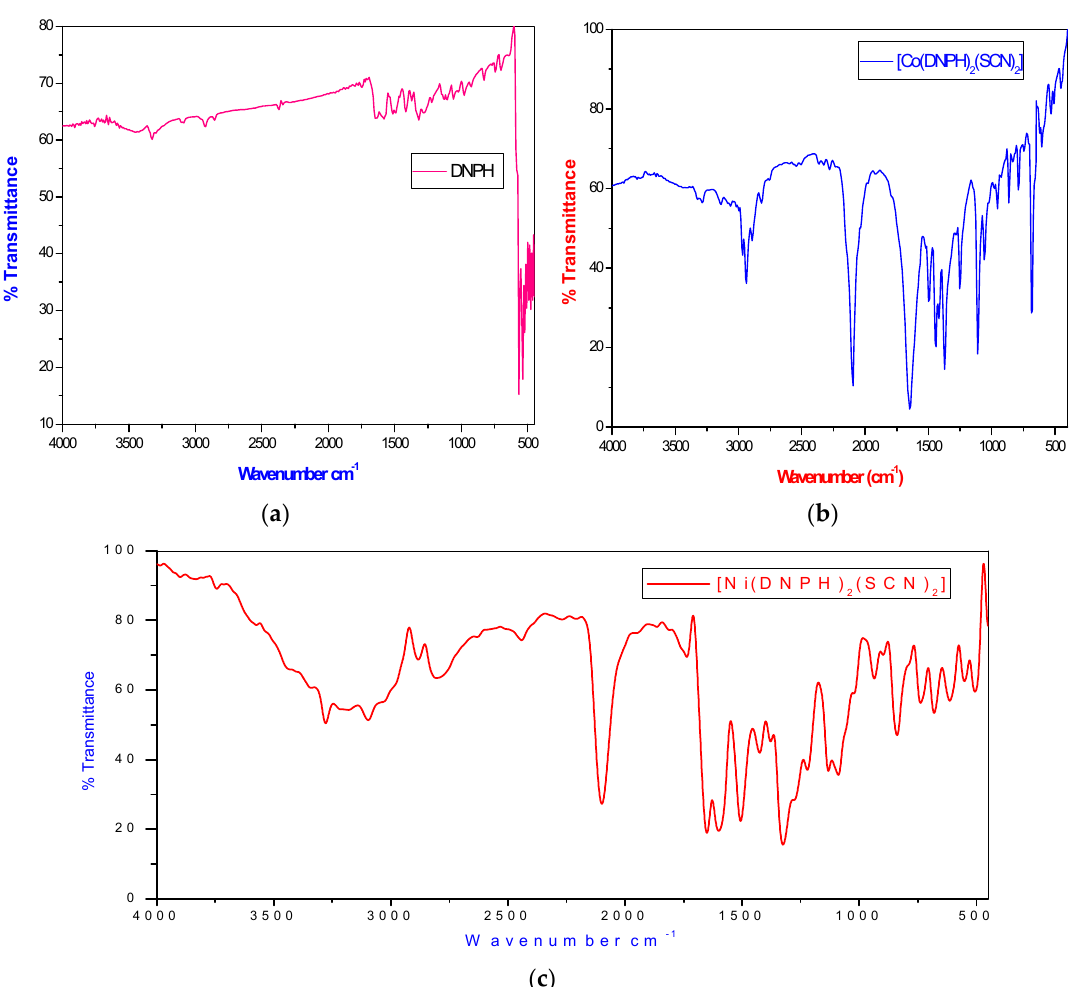
Figure 2. FTIR (Fourier transform infrared) spectra of ( a ) 2,4-dinitrophenylhydrazine (DNPH), ( b ) the Co(II) complex and ( c ) the Ni(II)complex.